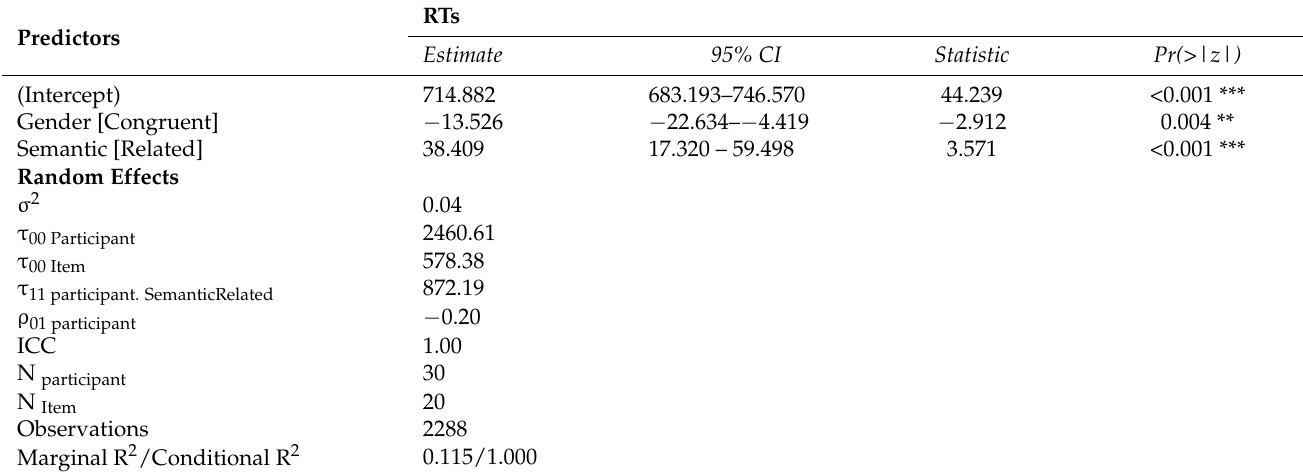
Table 3. General mixed effects model of best fit for RTs with gender congruency and semantic relatedness as two predictors including estimates, confidence intervals and p -values. The result demonstrated that both gender congruency and semantic relatedness had a significant impact on naming latencies. “***”: p < 0.001 and “**”: p <